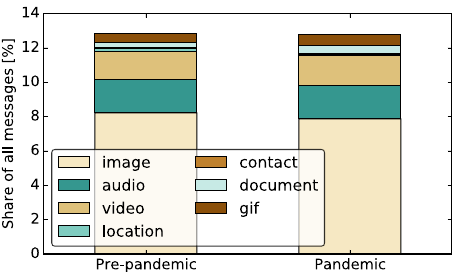
Fig. 7 Share of media for each 1-year period. The fi gure shows the share of sent media messages (e.g., images, video, and gifs) in the pre-pandemic year (left) compared to the pandemic year (right).